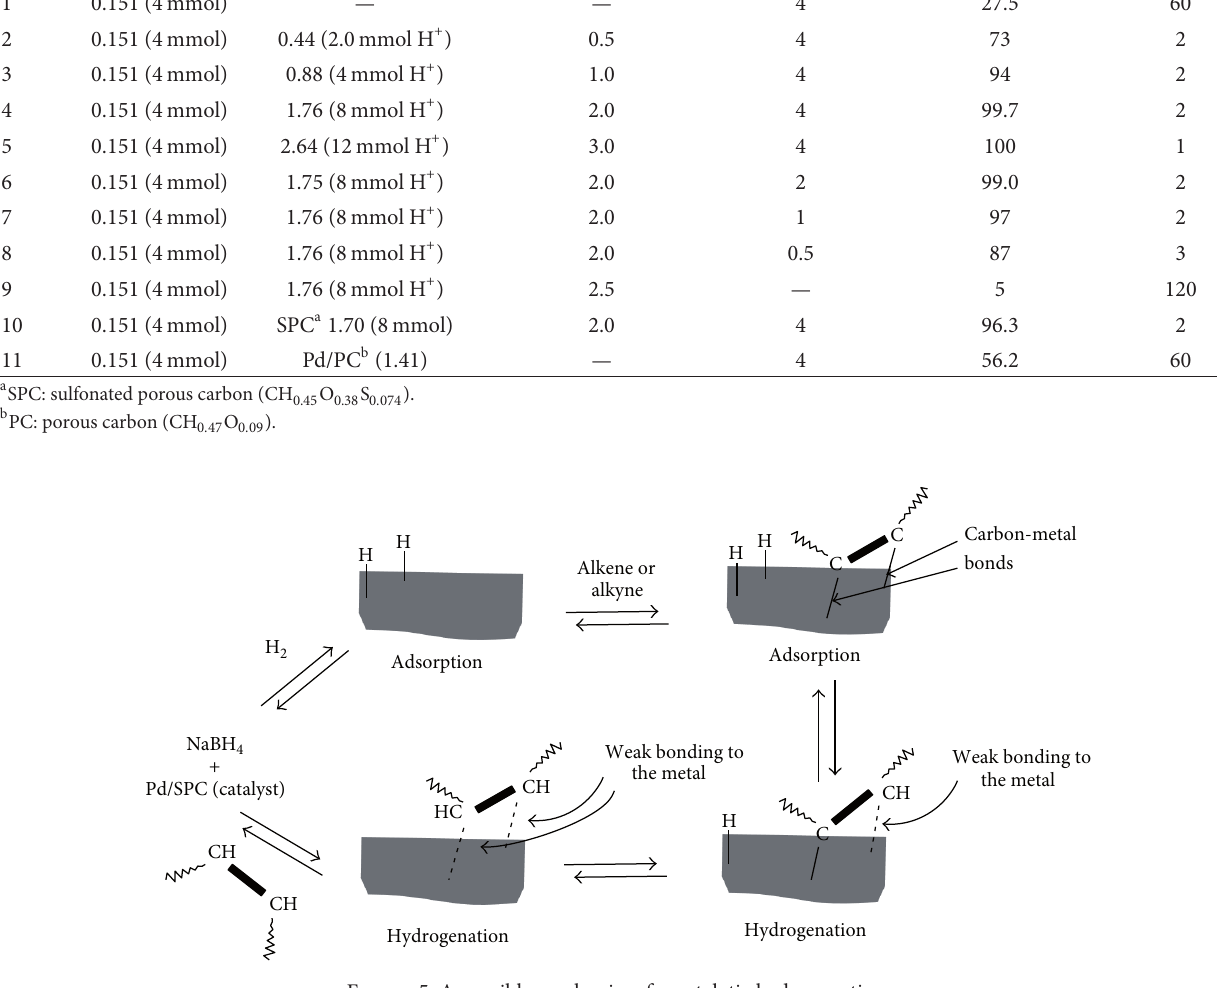
F 5: A possible mechanism for catalytic